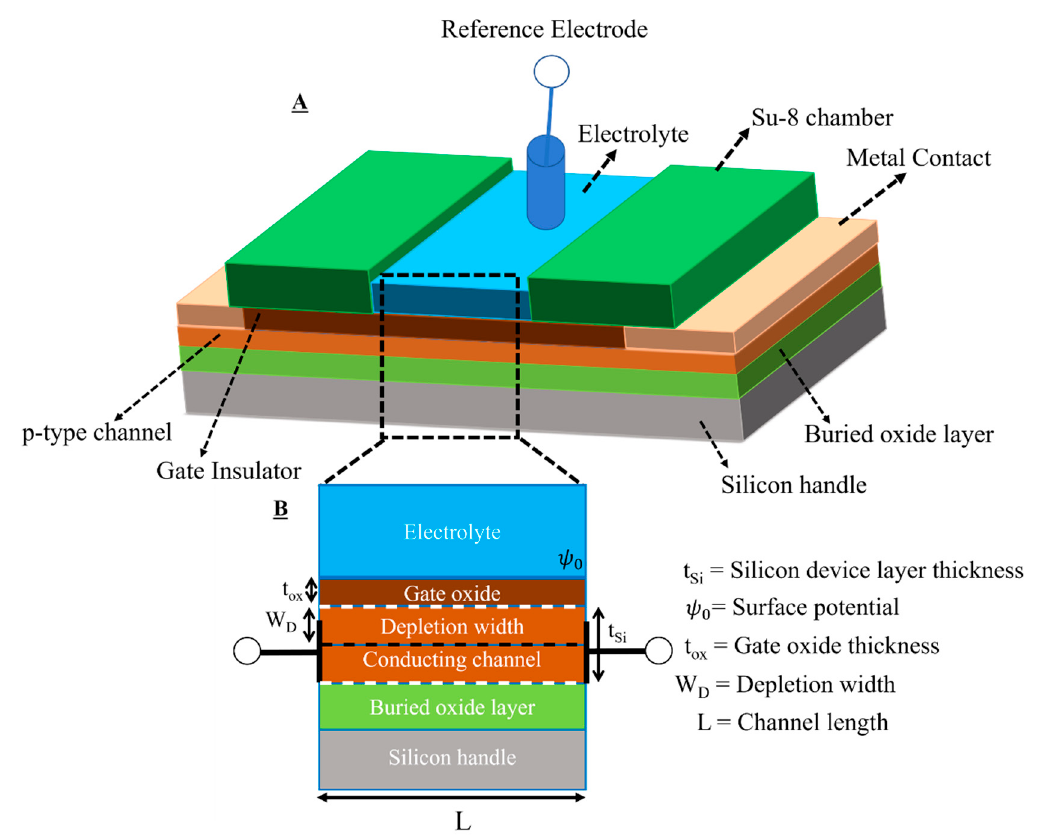
Figure 1. ( A ) Schematic of the proposed planar junctionless FETs and ( B ) cross-sectional view of the proposed device design.